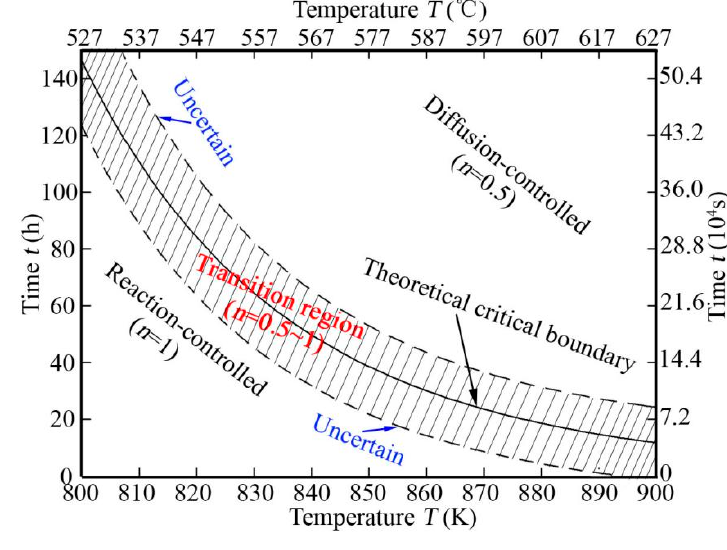
Figure 7. Time vs. critical temperature.